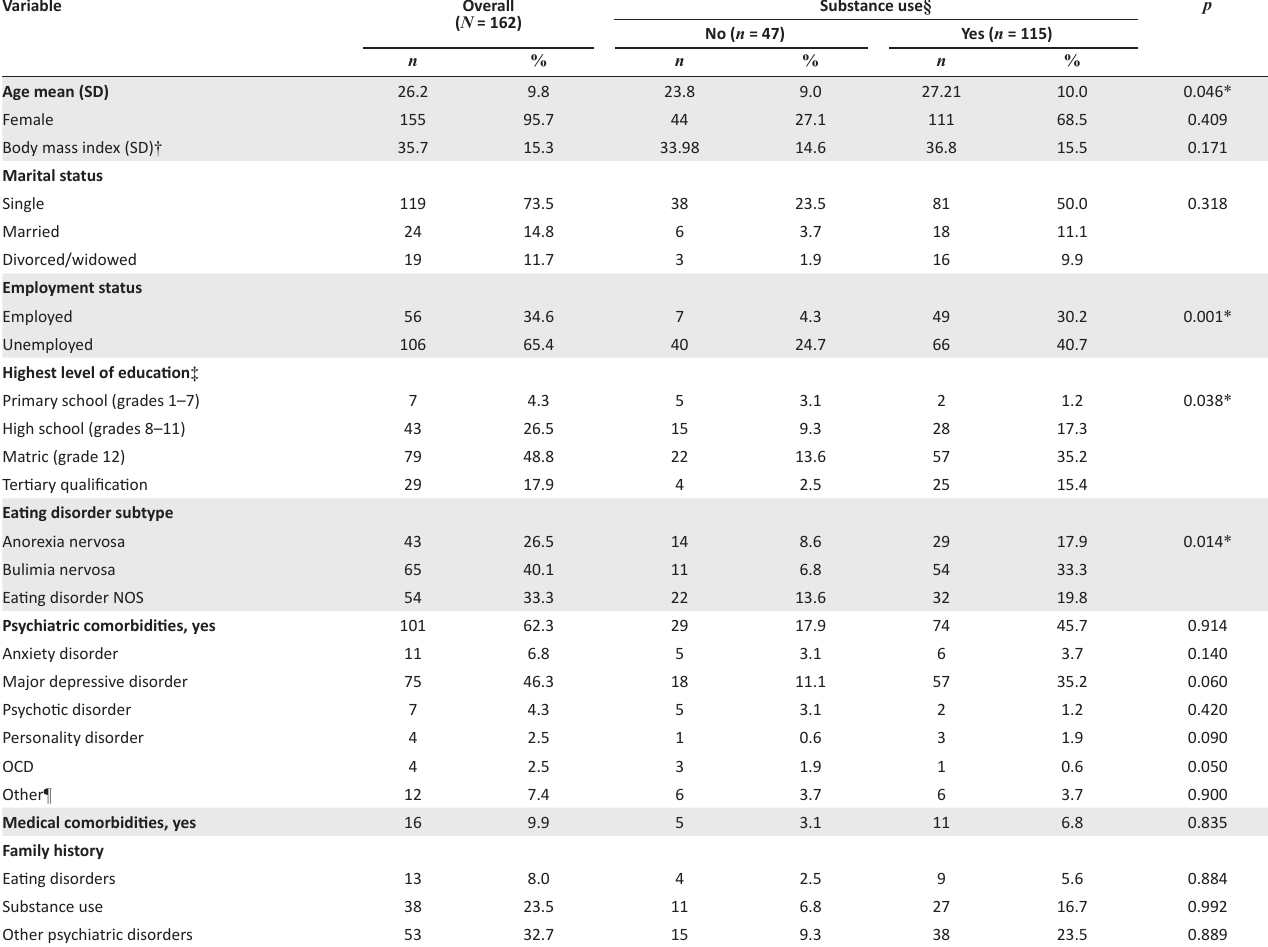
TABLE 1: Demographic and clinical characteristics of patients with eating disorder ( N = 162), showing differences between patients with and without substance use.